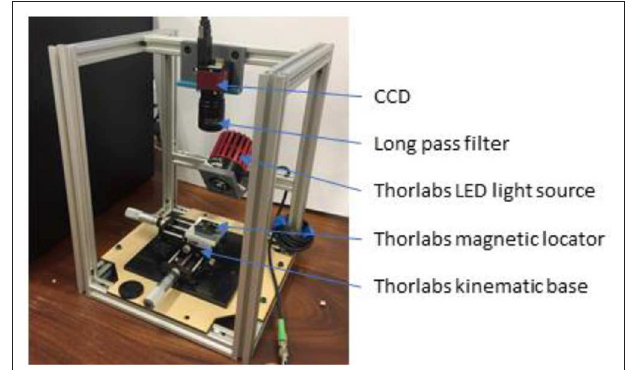
FIGURE 2 | Assembled test rig used for ICG excitation, specimen positioning and data